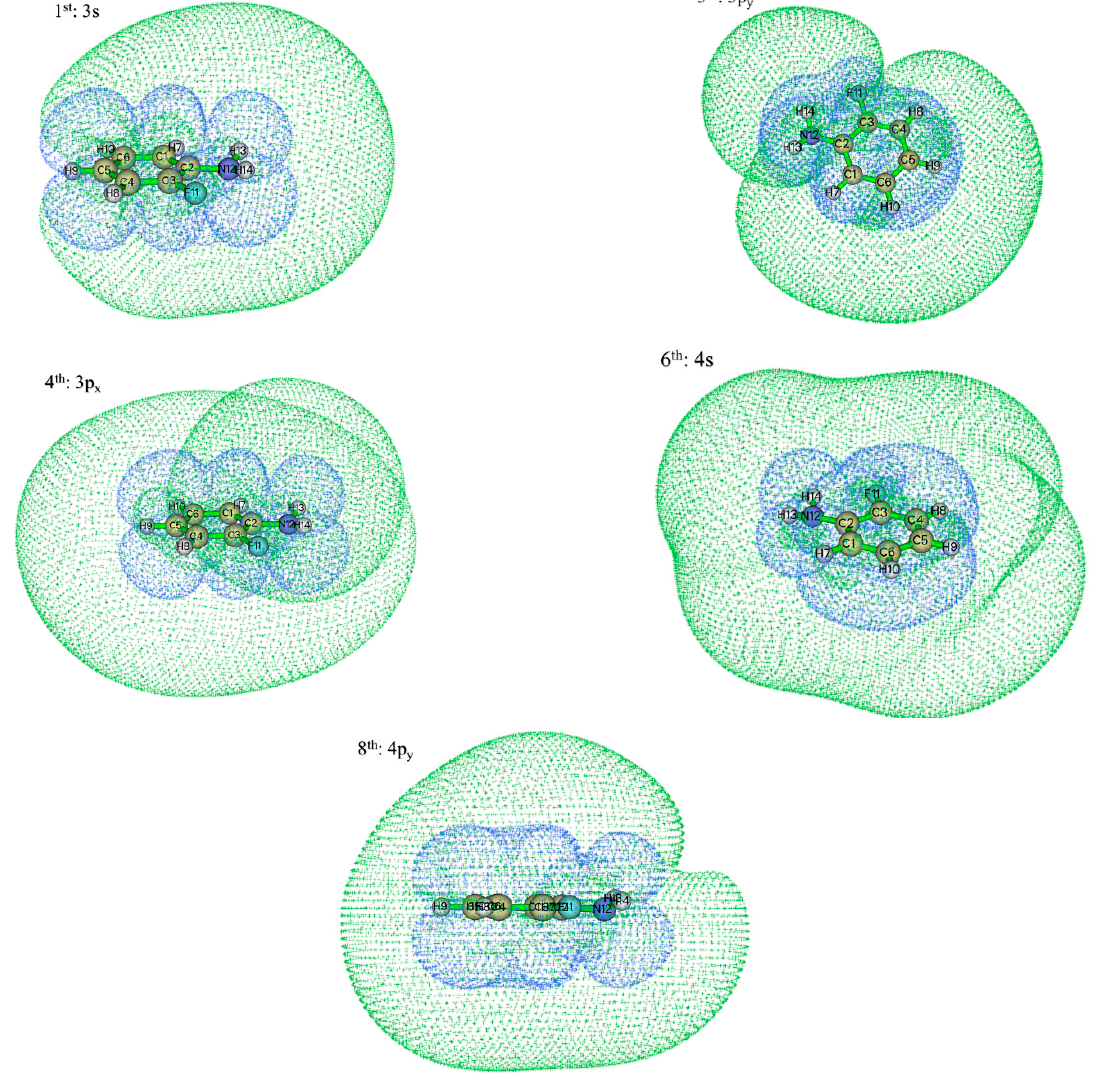
Figure A3. The molecular orbitals of the first to the fifth and eighth peaks.